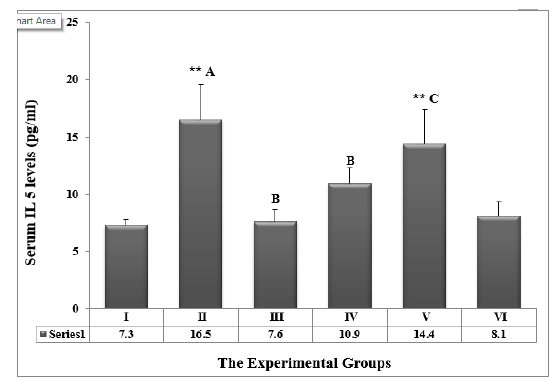
Figure3.The effect of guggulsterone on IL-5 levels in the serum of OVA-induced asthma in rats: Values are indicated as means ± Std. Error (n=8) for each group. Group I: Control group, Group II: Positive control group (with sensitization), Group III: Guggulsterone (25 mg/kg) with sensitization, Group IV: Guggulsterone (50 mg/kg) with sensitization, Group V: Prednisolone (4.12 mg/kg) with sensitization, Group VI: guggulsterone (50 mg/kg) without sensitization. ** symbol referred to significant different (p<0.001) compared to control group, unpaired test student t-test. Groups with non- identical letters are significantly different